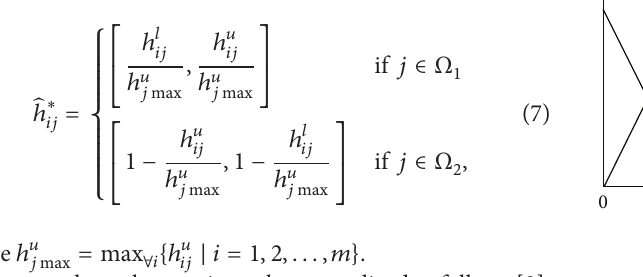
Figure 2: Illustration of transforming an interval to a linguisticterm in the